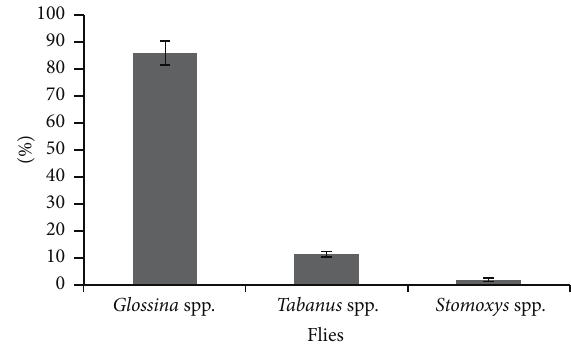
Glossina spp. Tabanus spp. Stomoxys spp. Flies Figure 5: Relative distribution of total fly catch.